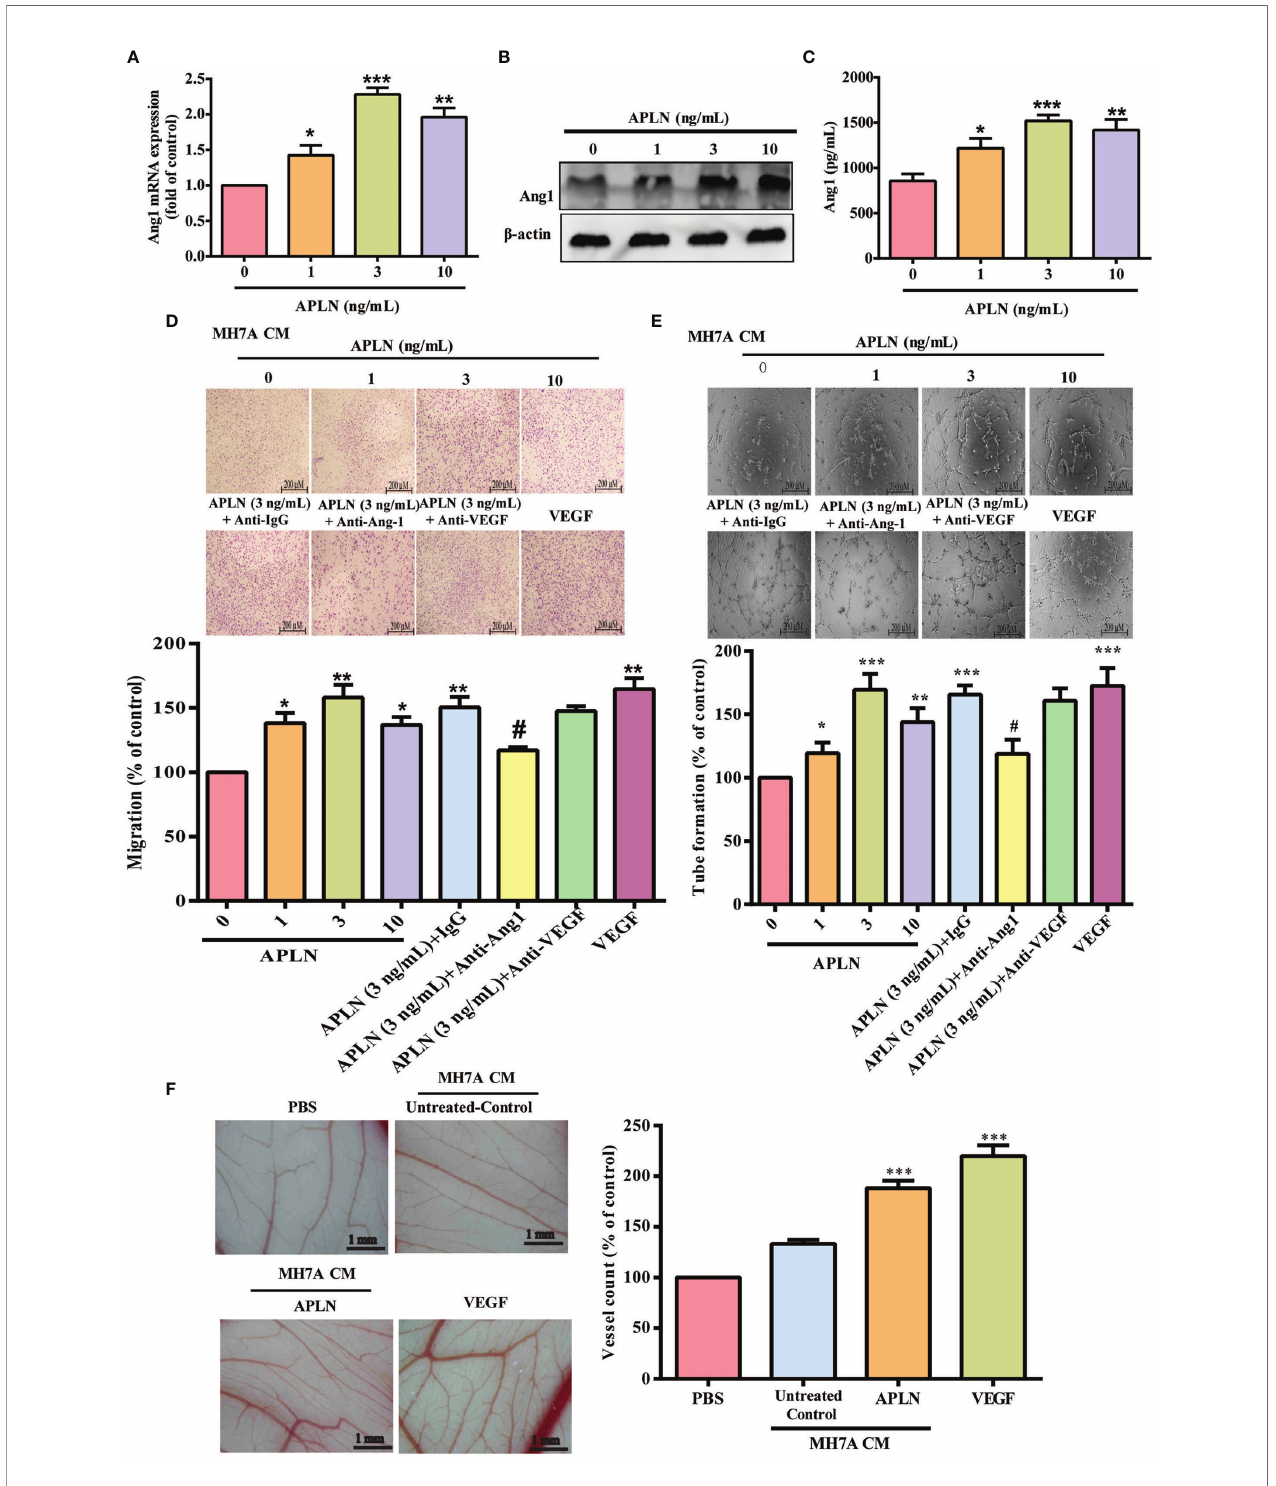
FIGURE 1 | APLN increases Ang1 expression in RASFs and promotes EPCs tube formation and migration. (A – C) RASFs were incubated for 24 h with APLN; Ang1 expression was quanti fi ed by qPCR, Western blot and ELISA assays. (D, E) RASFs cells were treat with APLN does manner for 24 h and collected conditioned medium (CM) was applied to endothelial progenitor cells (EPCs), then EPC migration and angiogenesis was measured. (F) Matrigel plugs containing CM from APLN- treated RASFs or VEGF (positive control) were applied to 6-day-old fertilized chick embryos for 4 days. CAMs were examined by microscopy and photographed, and vessels counted. * p < 0.05, ** p < 0.01 and *** p < 0.001 versus the control group; # p < 0.05 versus the APLN-treated